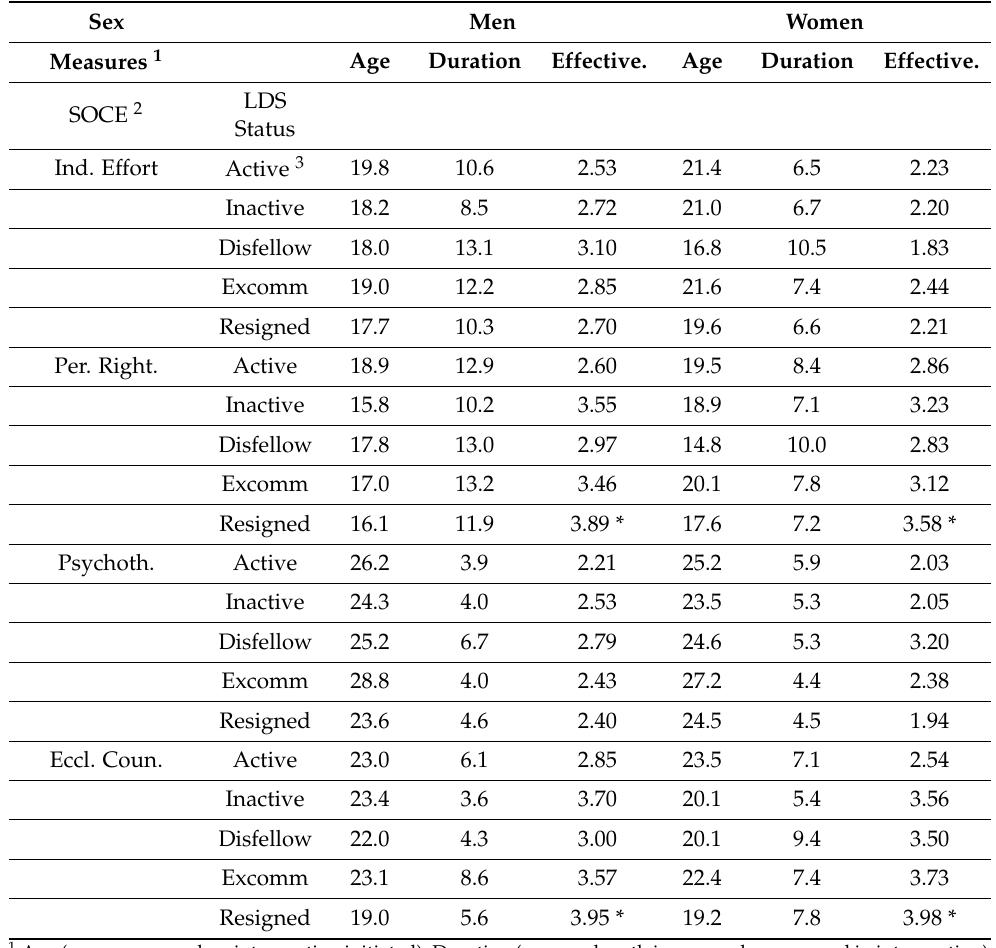
Table 2. Sexual Orientation Change Efforts by LDS